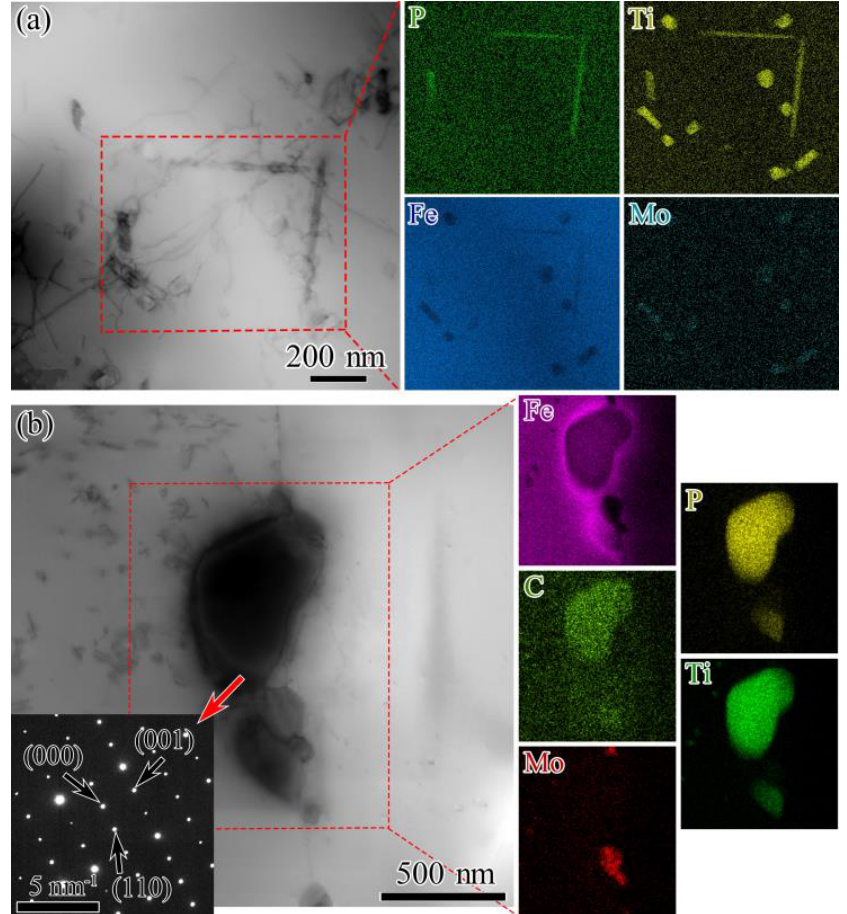
Figure 7. The TEM images of the 15Cr–15Ni–Ti–250P alloy after aging at 850 ◦ C for 1000 h: ( a ) needle-like phosphides and ( b ) blocky